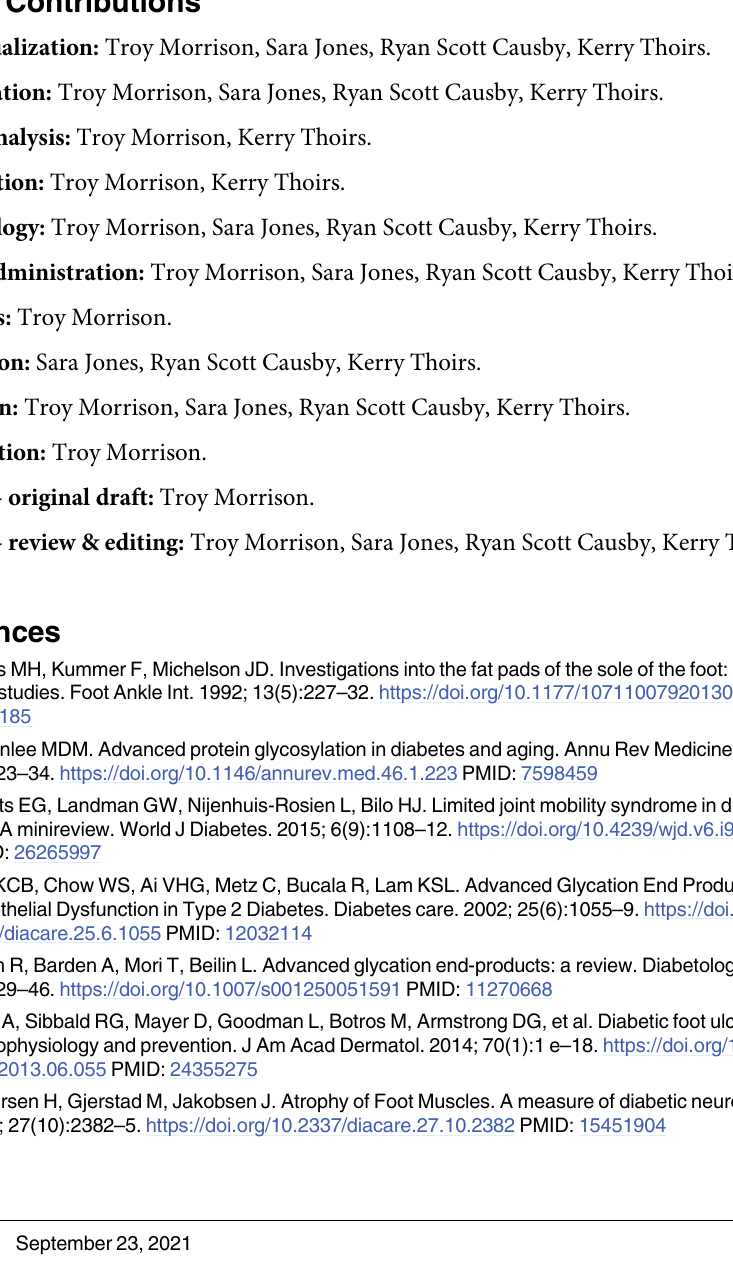
S1 Fig. Details of ultrasound tissue characteristic assessments for score